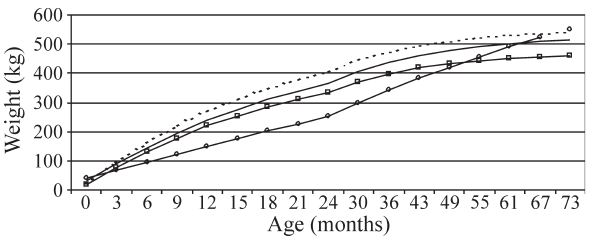
Figure 3 - Simulated growth curves based on high (-o-), low (- (cid:10) -) and av- erage (---) expected progeny differences (EPD) for the asymptotic weight estimated according to the Brody model, compared with the observed mean curve (-).